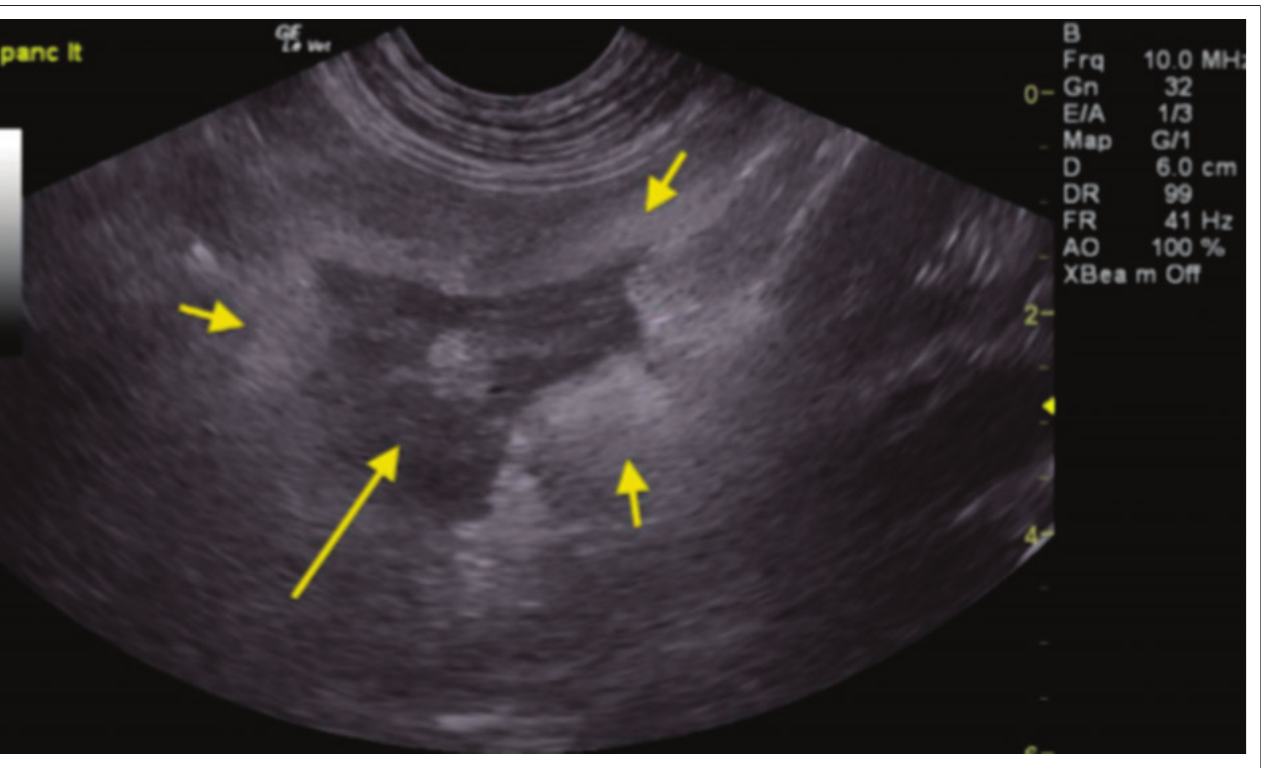
FIGURE 2: Example of pancreatitis affecting the left limb of the pancreas (group 1): Left limb of the pancreas demonstrating coarse mixed hypoechoic (long arrow) pancreatic parenchyma with ill-defined hyperechoic surrounding fat (small arrows) typical of acute pancreatitis.